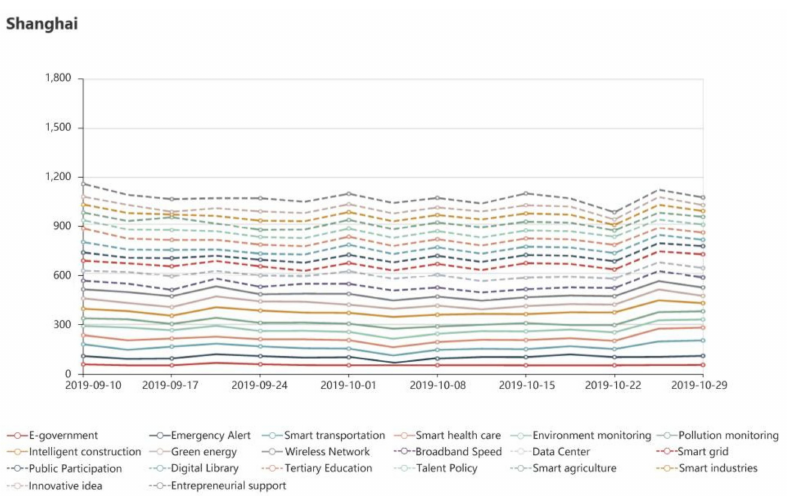
Figure 3. Temporal variations in CityIQ scores with twenty indicators, taking Shanghai as an example. With the historical CityIQ scores for the five dimensions and twenty indicators of different cities, it is possible to analyze the advantages and disadvantages for each city. Since the values of CityIQ are updated weekly, the average CityIQ scores of the major fifteen cities in the Yangtze River Delta from April to October 2019 were selected (Figure 4).